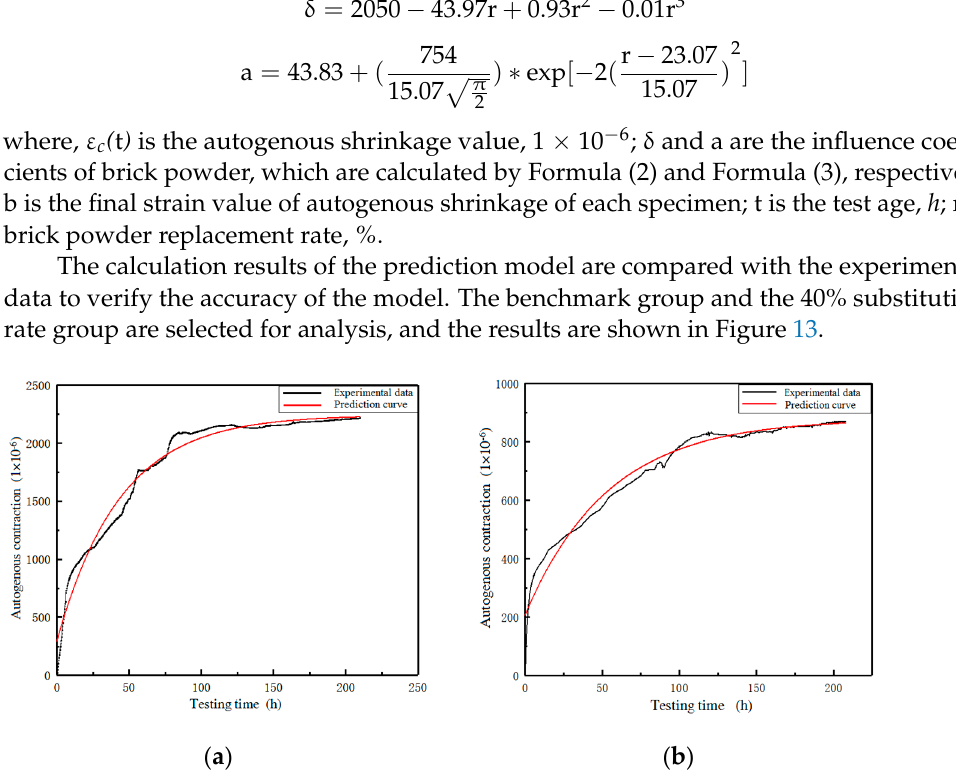
Figure 13. A comparison of the autogenous shrinkage test curve and prediction curve. ( a ) Baseline group; ( b ) 40% substitution rate group.